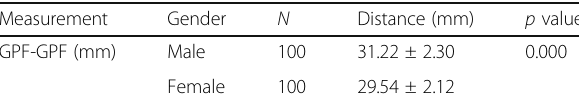
Table 11 Mean ± SD distance from the center of GPF to the center of opposite GPF based on